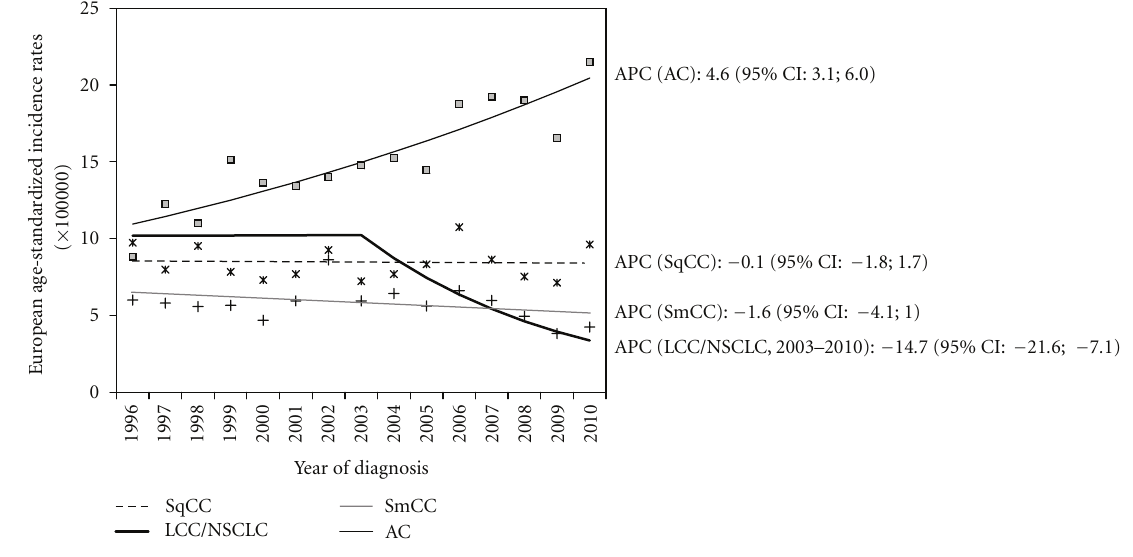
Figure 1: Trend of European age-standardised incidence rates of lung cancer histotypes: Ticino, 1996–2010.